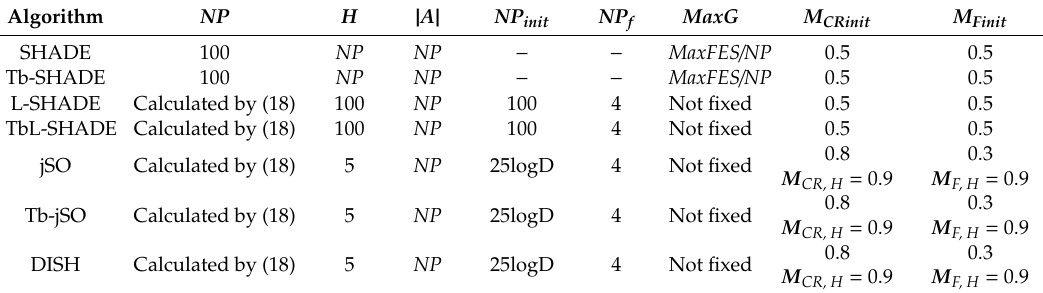
Table 5. Parameter setting of some algorithms.